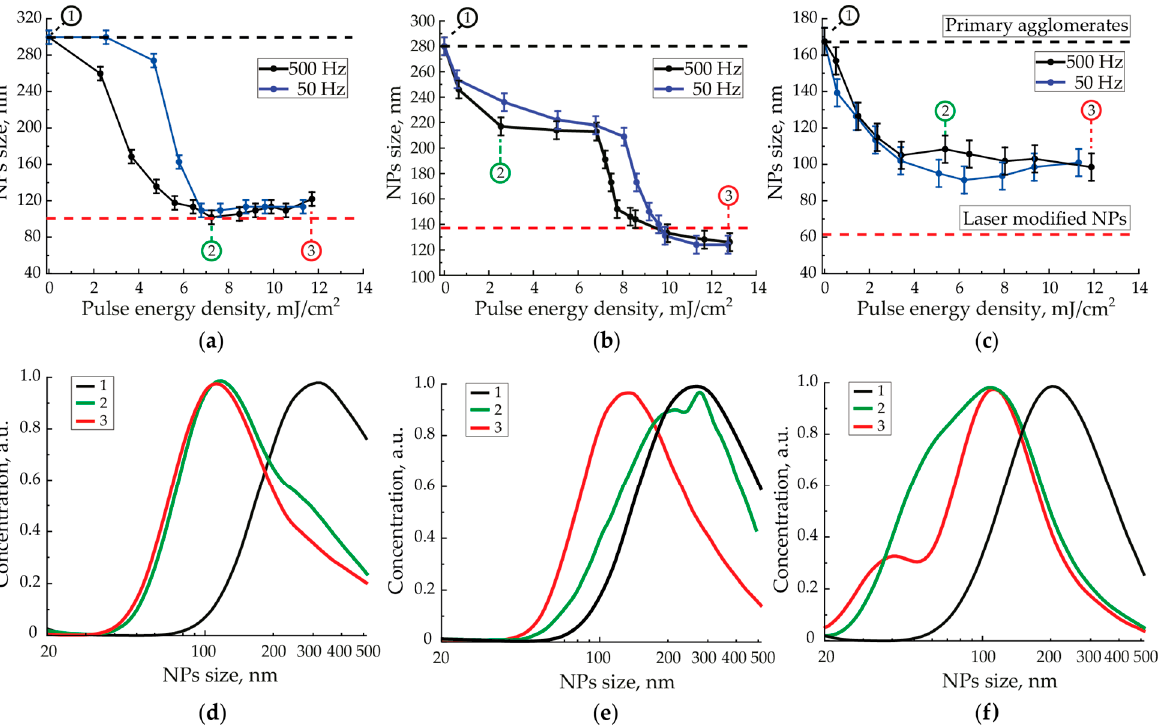
Figure 6. Dependencies of Pt ( a ), Au ( b ) and Ag ( c ) NPs size at the output of the focusing nozzle right after the cell on the pulse energy density of laser radiation with the wavelength of 1053 nm at the pulse repetition rate of 500 Hz and the aerosol flow rate of 50 mL/min. The shrinkage curve data for Au is from [11]. Size distributions of initial and laser modified Pt ( d ), Au ( e ) and Ag ( f ) NPs agglomerates taken from 1, 2 and 3 measurements presented in ( a – c ).